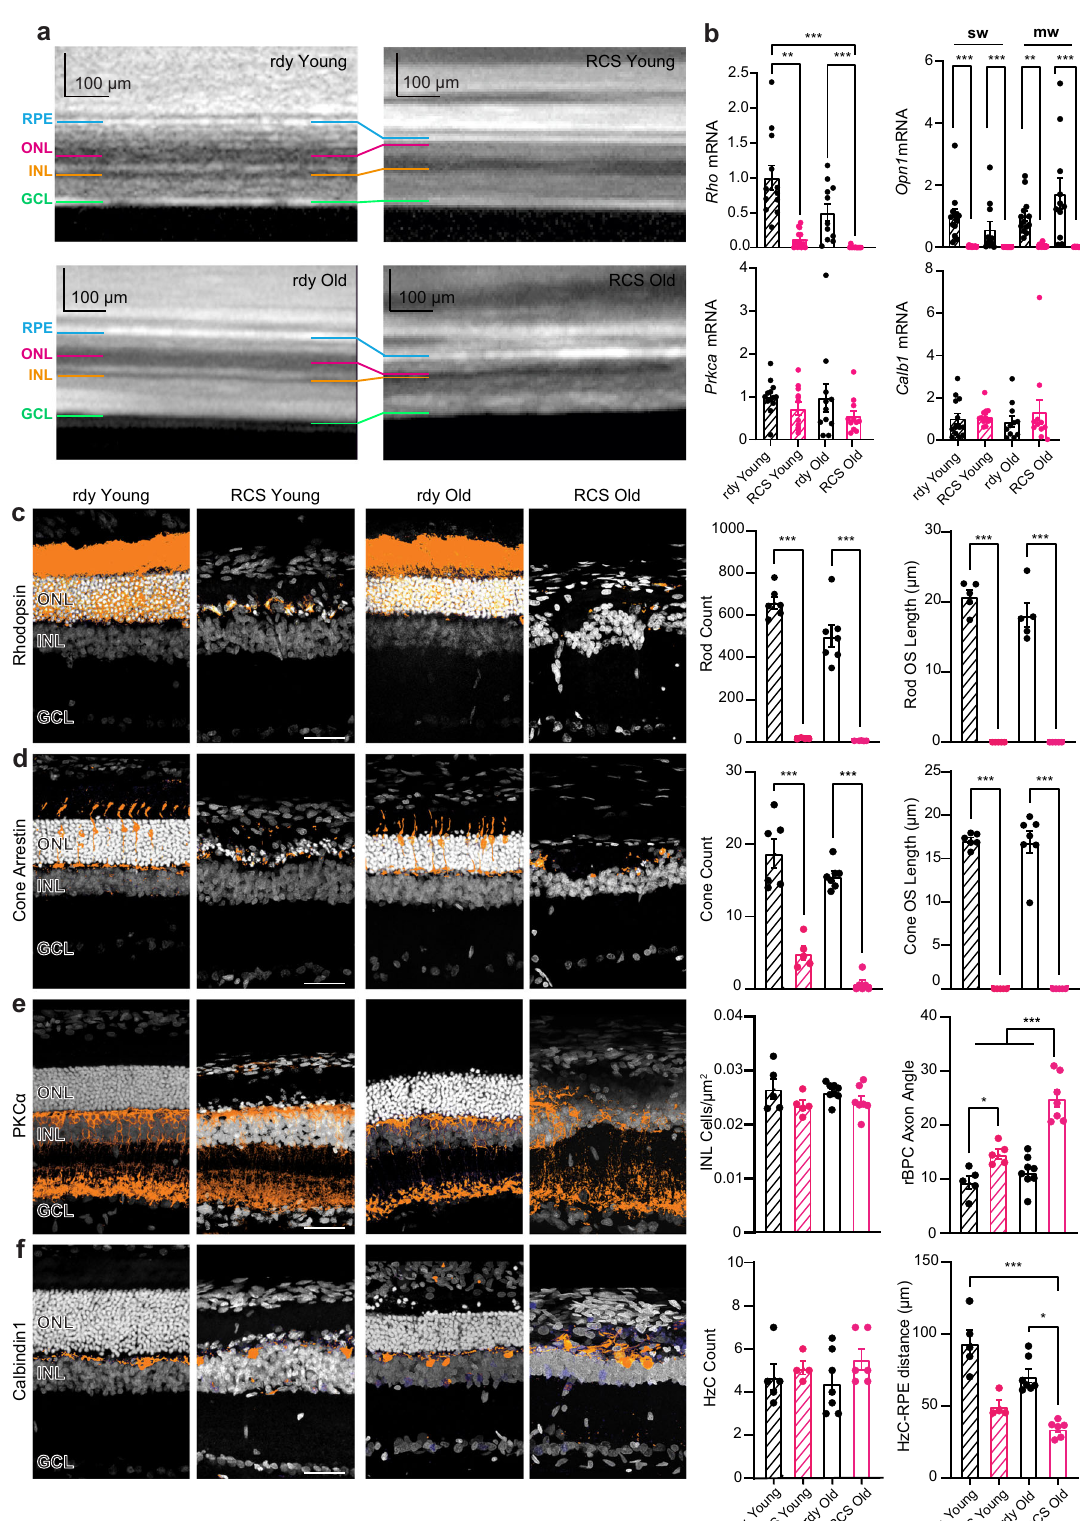
P3HT-NPs distribute evenly in the subretinal space of both young and old RCS rats . P3HT-NPs were obtained by the reprecipitation method in the absence of surfactant, as previously reported 40,41 and checked by scanning electron microscopy (SEM) and dynamic light scattering (DLS). SEM revealed